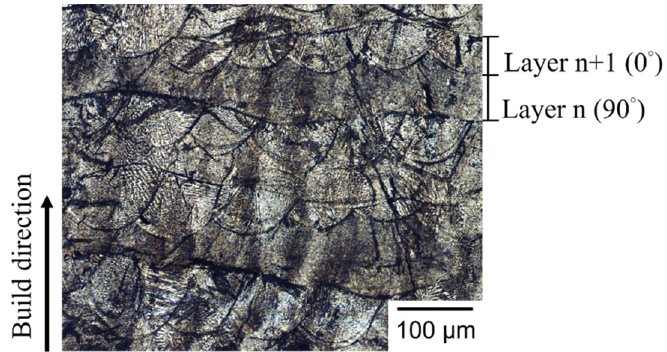
Figure 7. OM micrograph of typical layer morphology of SLM build.